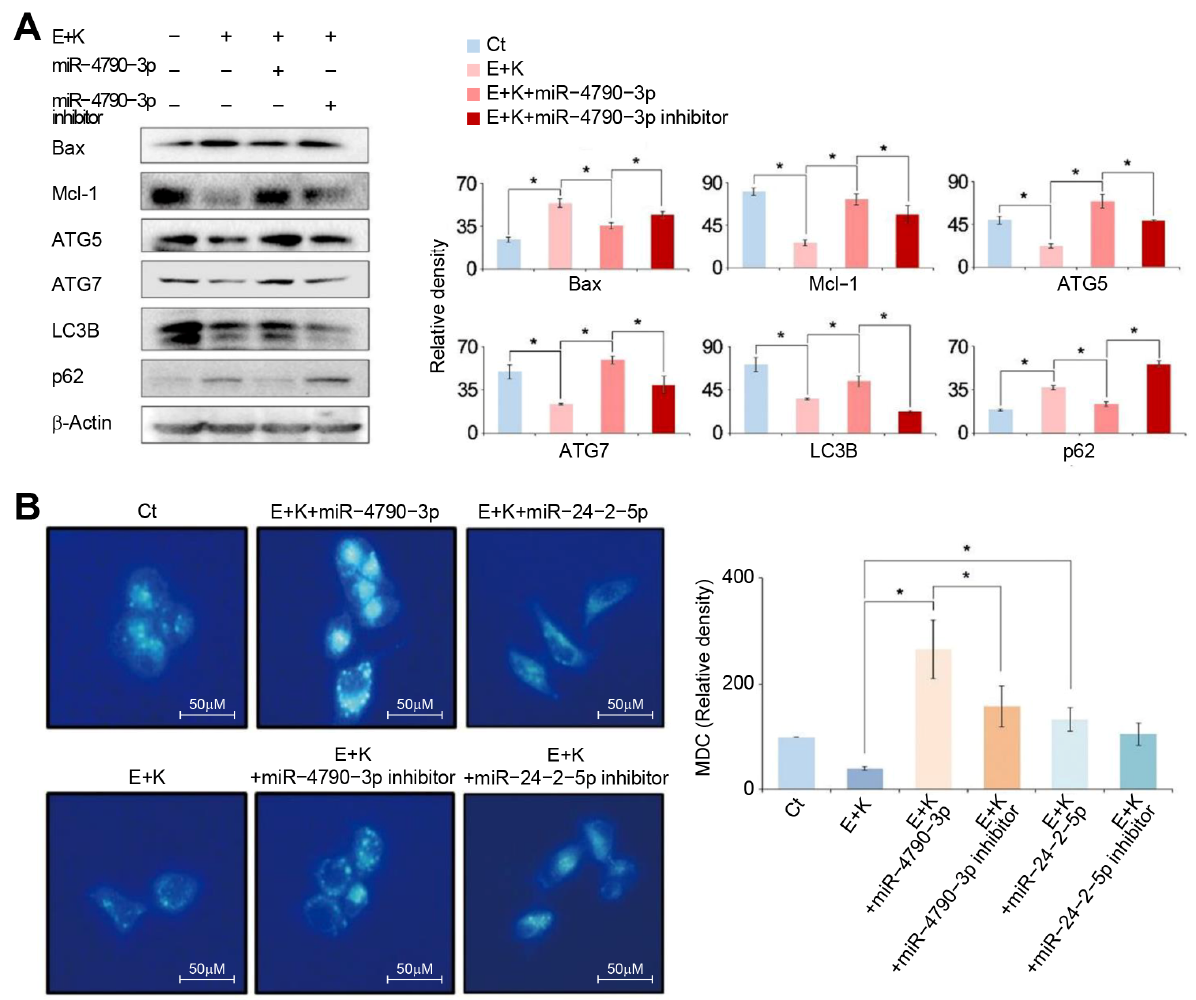
Figure 4. The miR-4790-3p inhibition test for the determination of the role of miR-4790-3p. ( A ) Western blot analysis in HepG2 cells with miR-4790-3p inhibition following individual treatments. Inhibition of miR-4790-3p led to upregulation of Bax, downregulation of Mcl-2, and antiapoptotic alterations (lower expression of ATG5, ATG7, and LC3B and higher expression of p62). ( B ) Determination of the degree of autophagy using immunofluorescences with MDC staining. The degree of autophagy was determined in HepG2 cells with up- or downregulation of miR-4790-3p and miR-24-2-5p, respectively, following individual treatments. While overexpressing miR-4790-3p promoted autophagy (bright blue), inhibiting miR-4790-3p led to reduced autophagy (darked blue). Overexpressing or inhibiting miR-24-2-5p led to similar results as for miR-4790-3p; however, the results were not as prominent as for miR-4790-3p. Values are presented as means ± standard deviations of three independent experiments. Note: * p < 0.05. Abbreviations: Bax, Bcl-2-like protein 4; E, everolimus; K, Ku0063794; Mcl-1, myeloid cell leukemia 1; MDC, monodansylcadaverine.